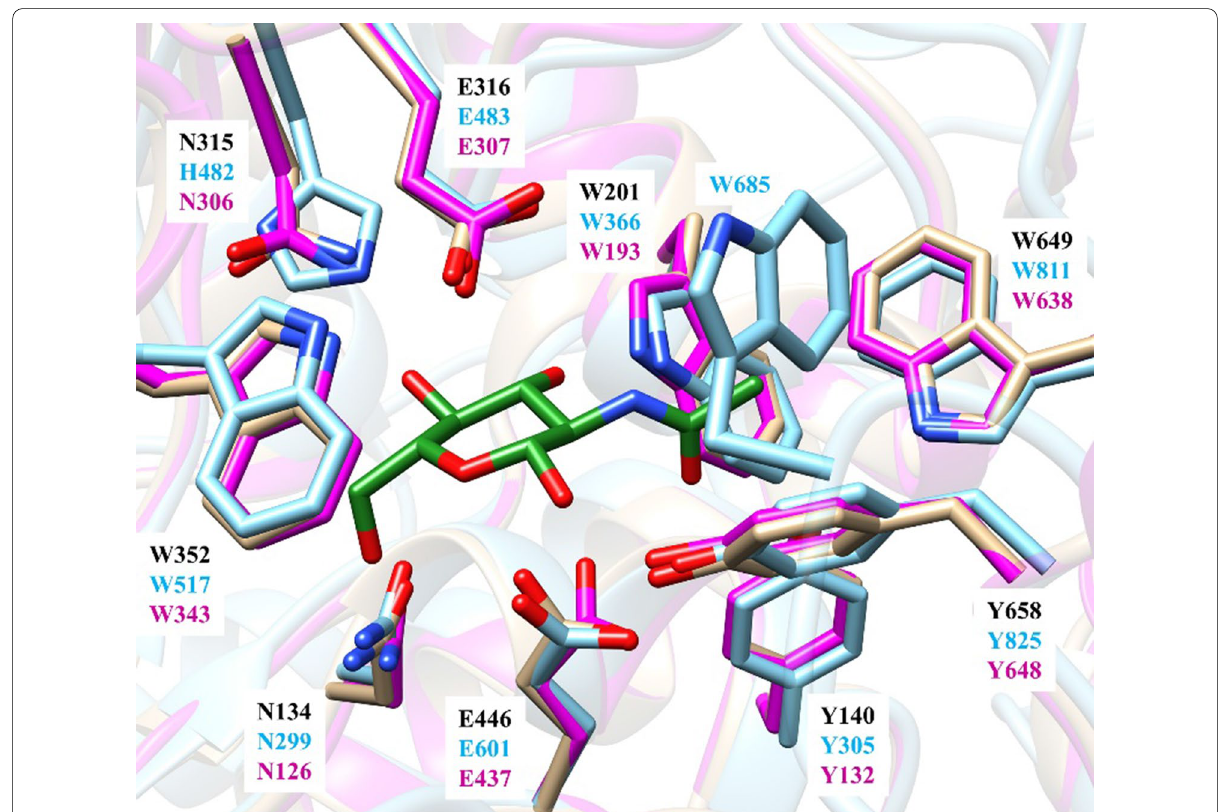
Fig. 8 Structural overlay of the active sites of hNAGLU (PDB ID:4XWH, golden), CpGH89 (cyan) in complex with GlcNAc (green) (PDB ID: 2VCA), and Bt3590 model (magenta). The GlcNAc ligand (green) and the key residues in the active sites (labeled in black for hNAGLU, cyan for CpGH89, and magenta for Bt3590) are shown in stick representations. The figure was generated with UCSF Chimera (Pettersen et al.